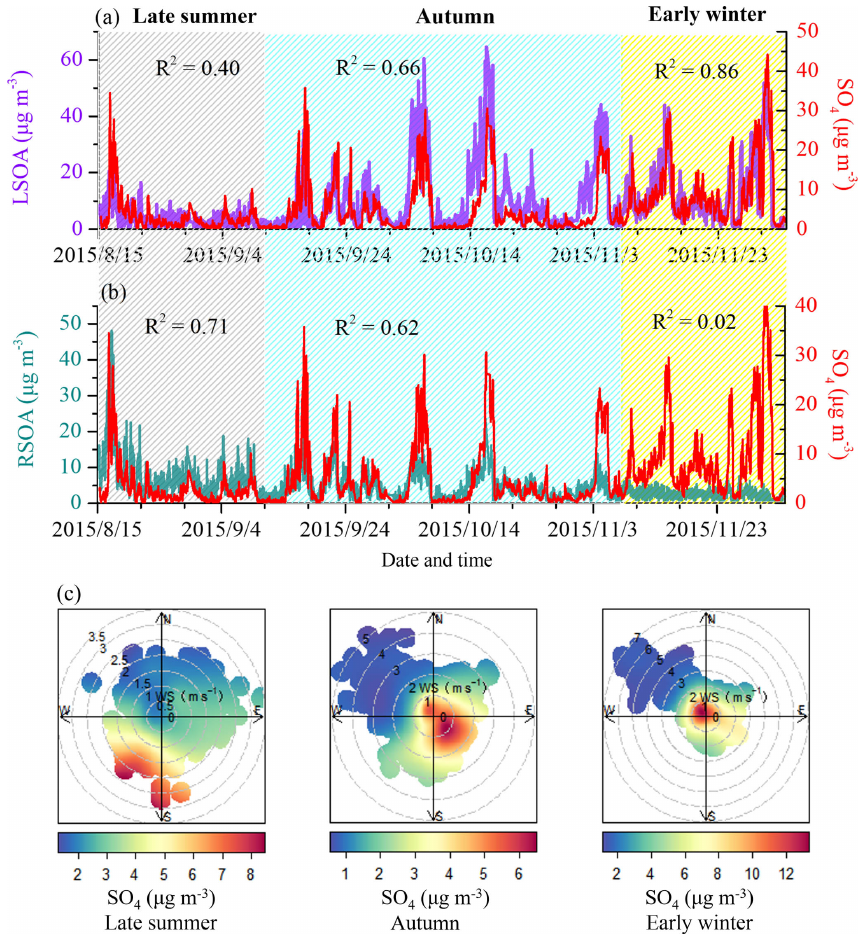
Figure 3. (a) Correlation between time series of SO 4 and LSOA; (b) correlation between time series of SO 4 and RSOA; (c) bivariate polar plots of SO 4 during late summer (left), autumn (middle) and early winter (right) as functions of wind direction and wind speed (ms − 1